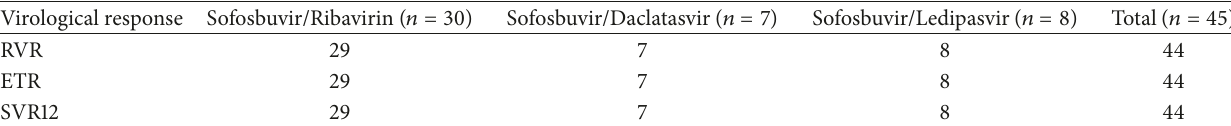
Table 3: Virological response to DAA